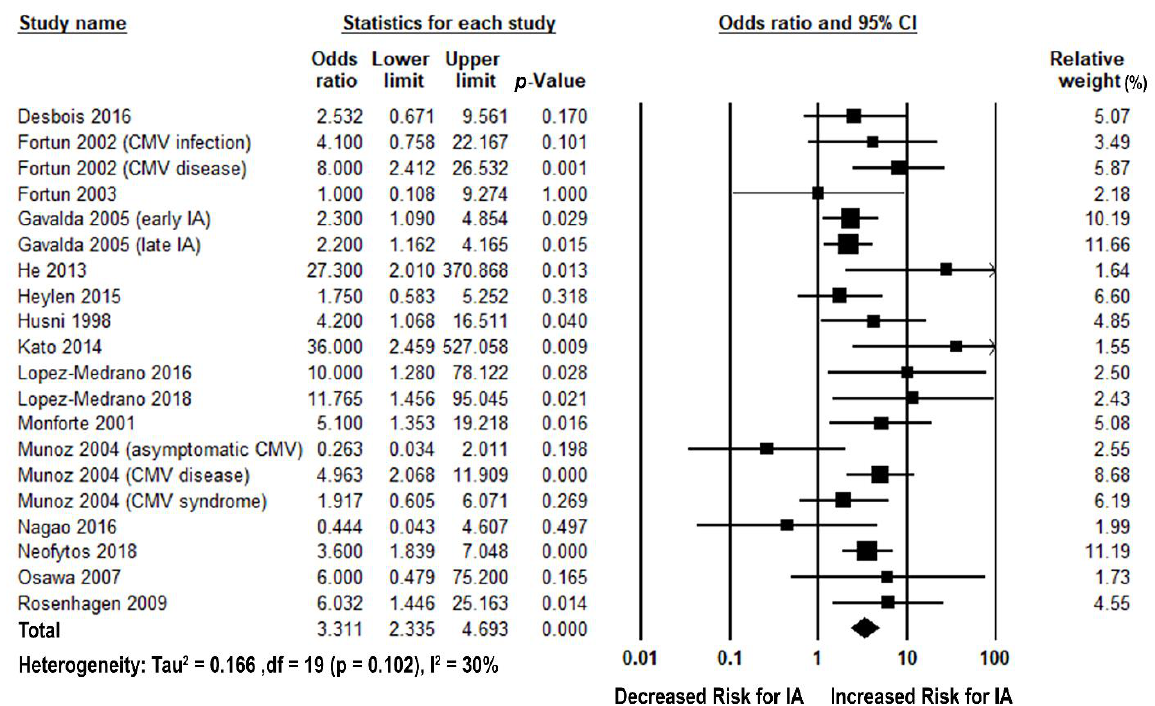
Figure 2. Forest plots of odds ratios for the association between CMV and post-transplant IA. CI: confidence interval; IA: invasive aspergillosis.